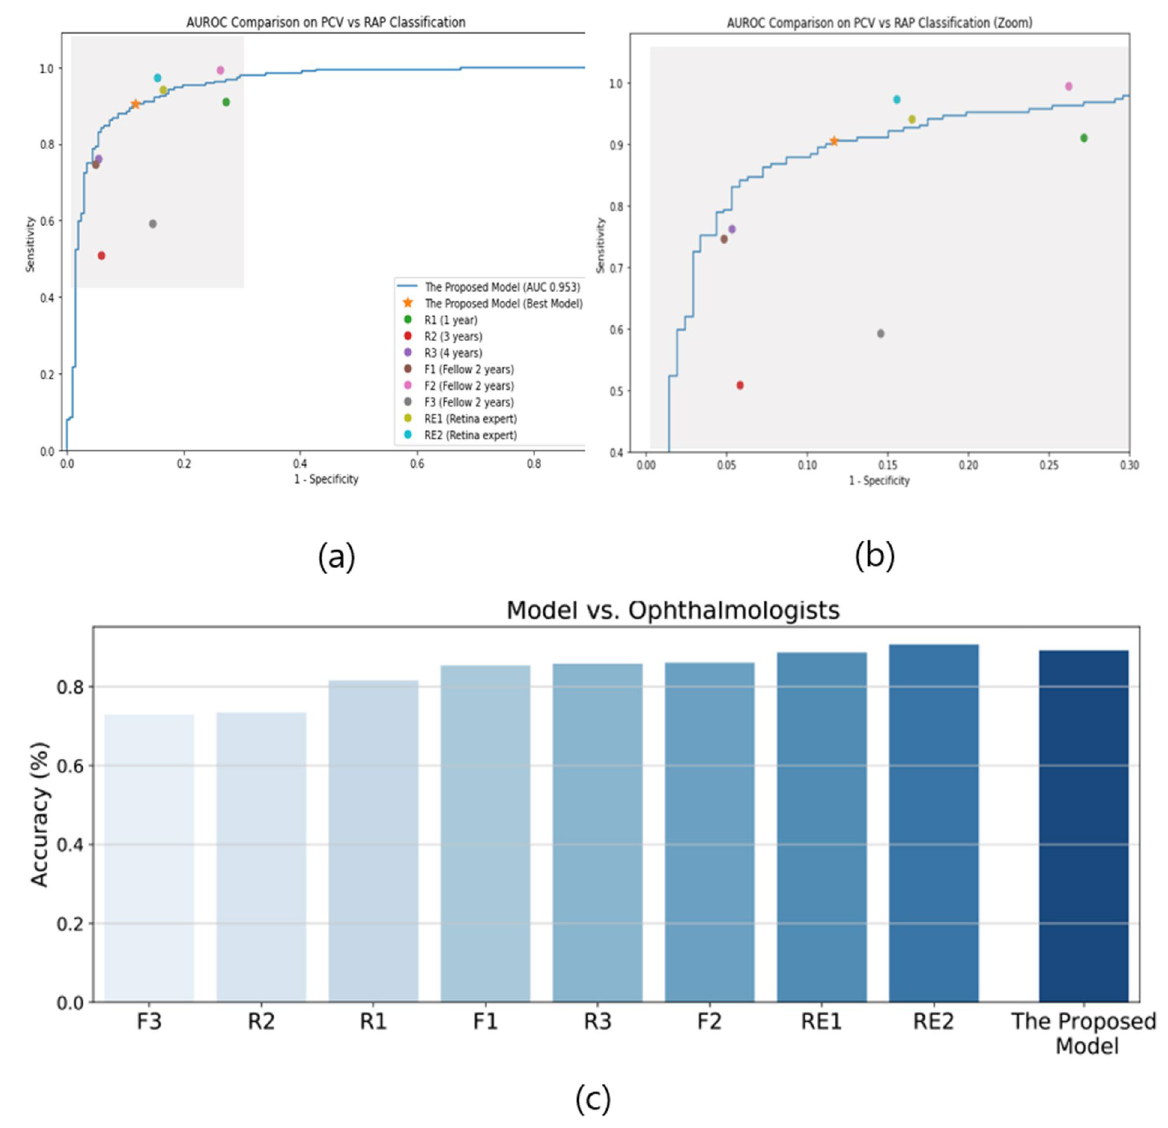
Figure 1. Performances of the classification PCV vs. RAP. ( a ) Performance comparison between our model and the ophthalmologists. The blue line (ROC curve) is created by sweeping a threshold over the predicted probability for a specific clinical diagnosis. ( b ) An expanded version of ( a ). ( c ) Accuracy of our model in comparison to that of the eight ophthalmologists. The performance of our model is better than that of most of these ophthalmologists. AUROC, area under the receiver operating characteristic curve; PCV, polypoidal choroidal vasculopathy; RAP, retinal angiomatous